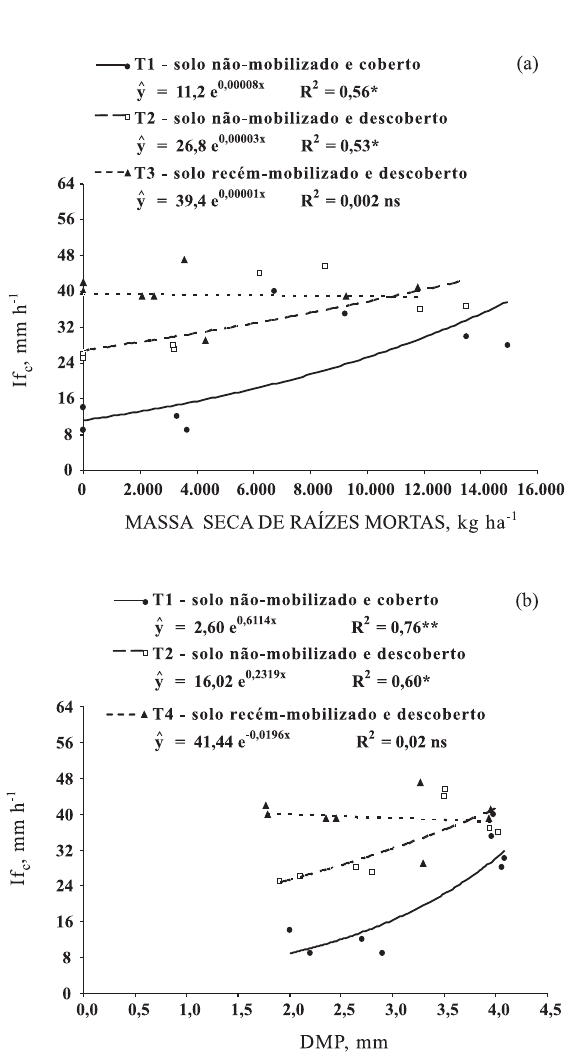
Figura 3. Relação da taxa constante de infiltração de água no solo -If - com a massa de raízes mortas c secas (a) e com o diâmetro médio ponderado – DMP - de agregados (b) na camada de 0 a 10 cm, em distintas condições físicas da camada superficial do solo, independentemente